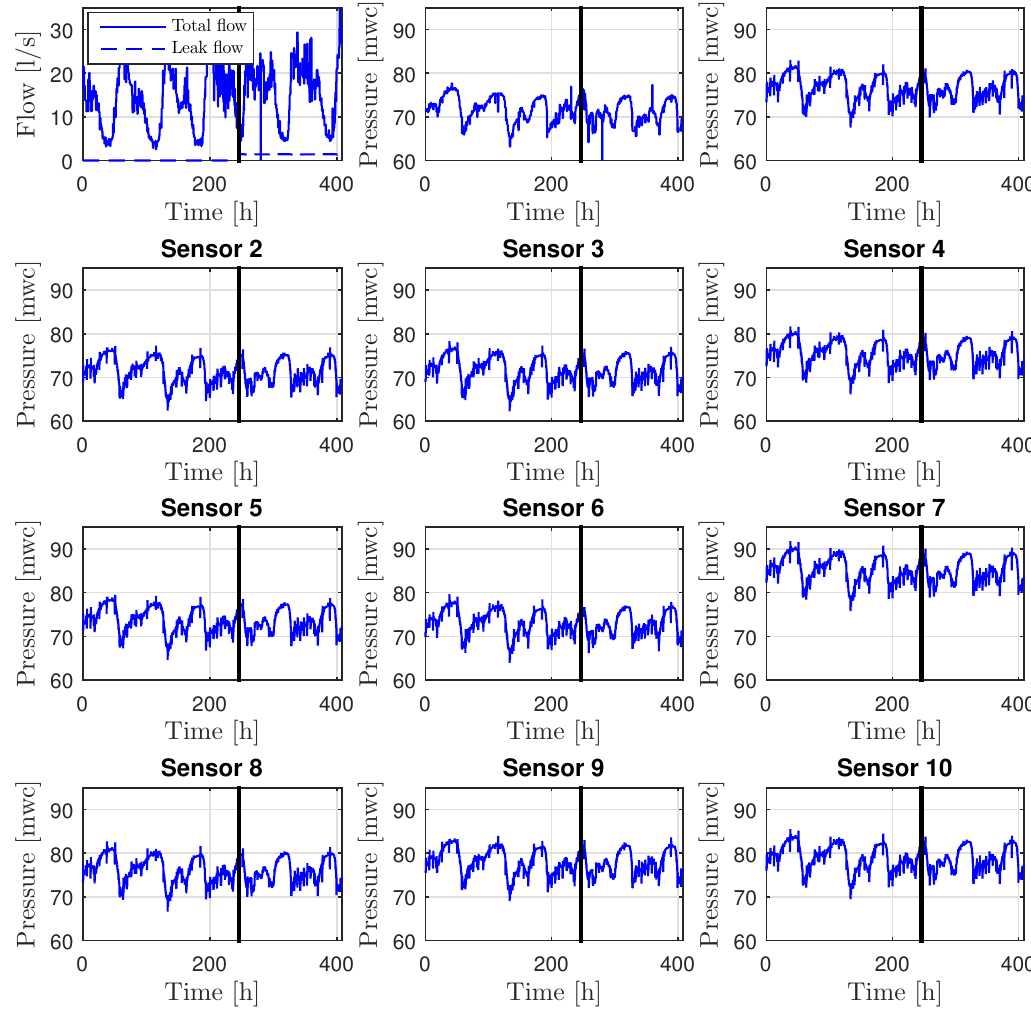
Figure 12. Measurements in the Madrid DMA under nominal conditions (before vertical line) and faulty conditions (after vertical